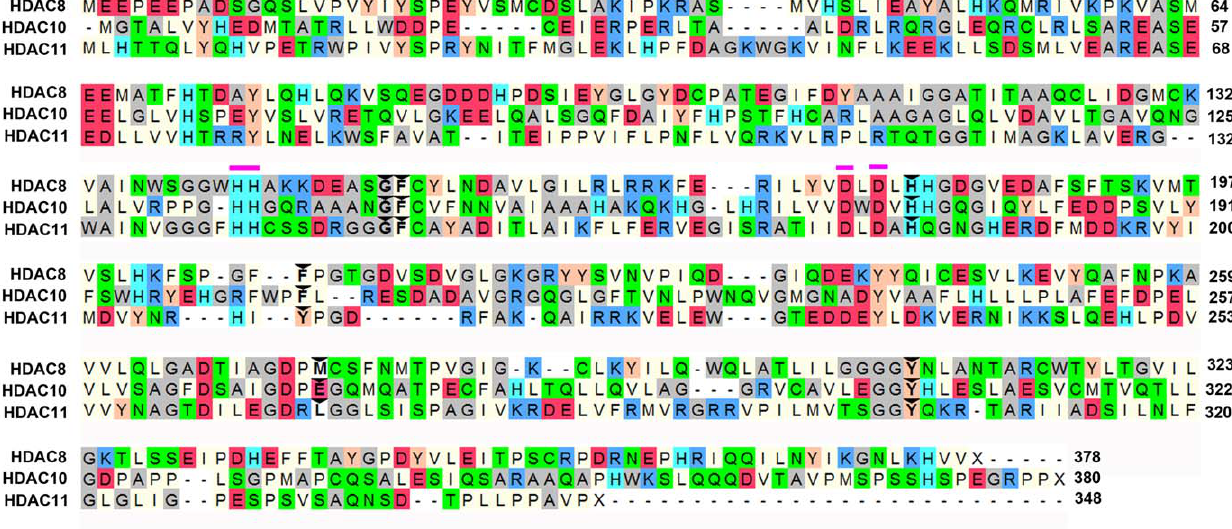
Figure 2. Sequence alignment of HDAC8, 10, and 11 enzymes. The pairs of histidine and aspartate residues involved in charge relay system are marked with pink bar. The amino acid residues forming tunnel are marked with black carets.